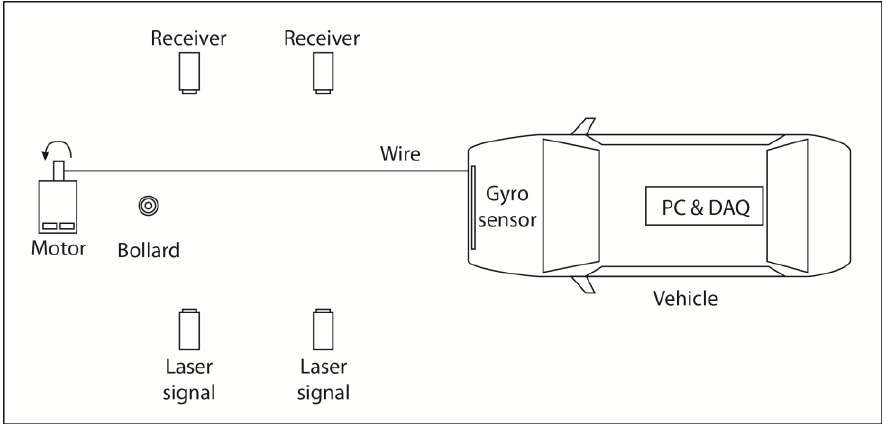
Figure 14. Schematic of the experiment.